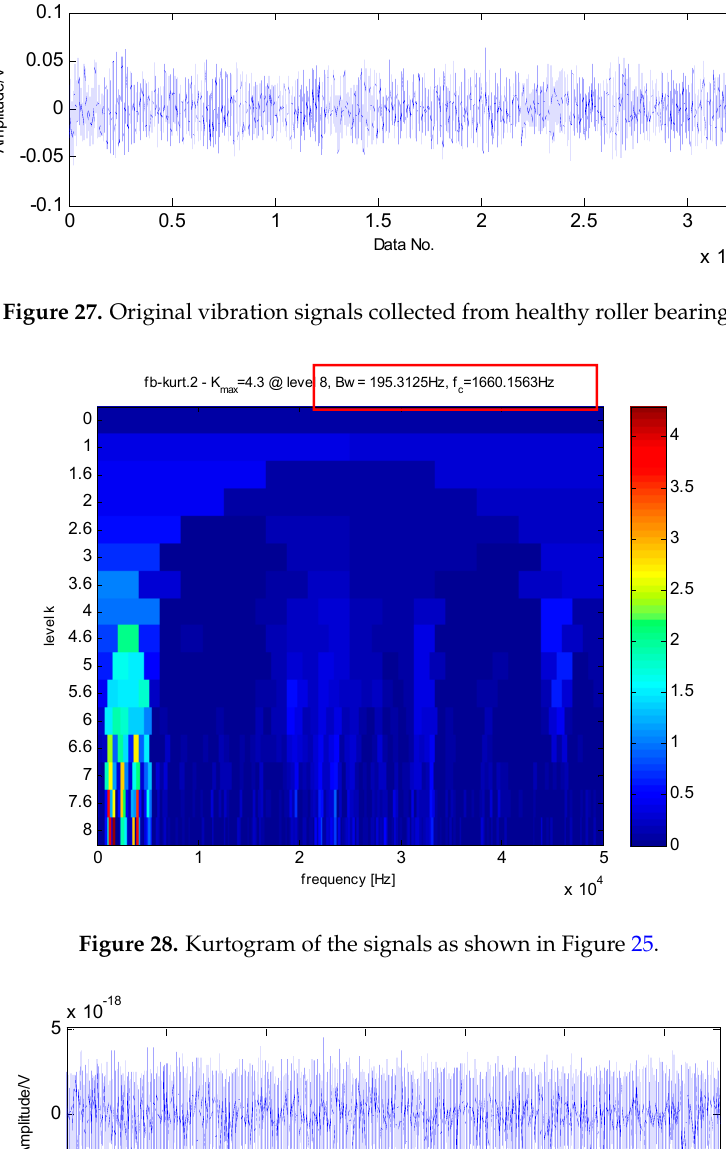
Figure 30. Random sampling of transient impact component through Gaussian random matrix. Figure 31. The detected fault characteristic frequency through matching pursuit. Figure 32. Second harmonic of the detected fault characteristic frequency through matching pursuit.